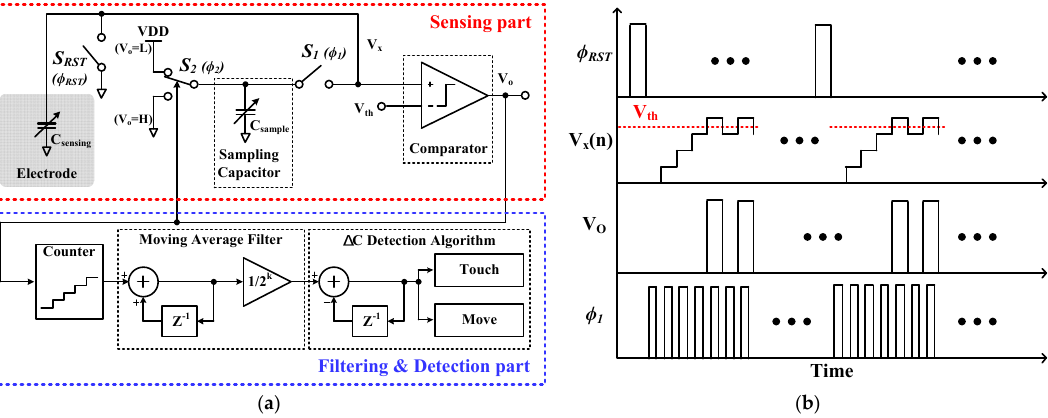
Figure 2. ( a ) Overall architecture of the proposed capacitance readout circuit; ( b ) timing diagram.